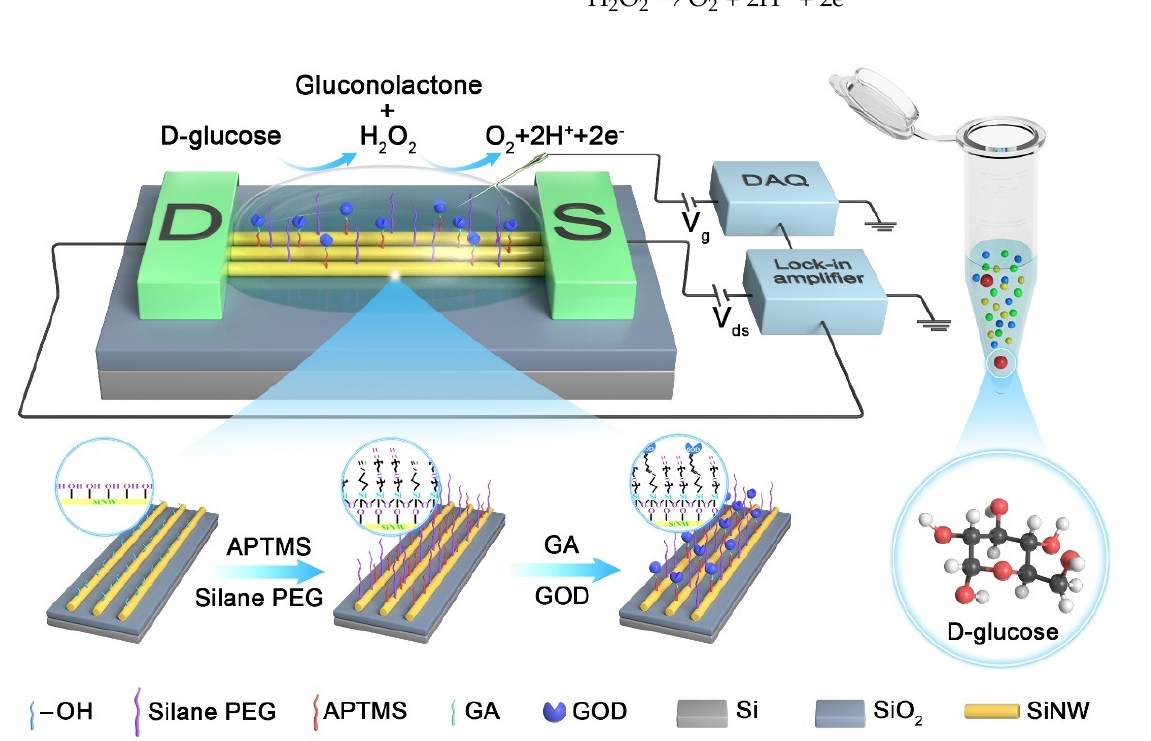
Figure 3. Schematic diagram of surface modification and glucose detection principle of APTMS/PEG/SiNW − FET glucose biosensor.